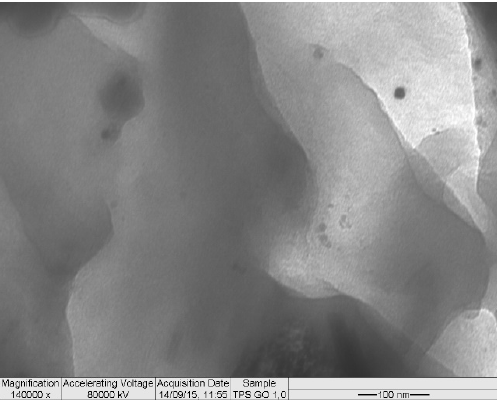
Figure 4. TEM image for TPS with GO incorporated at 1.0 mass% content.